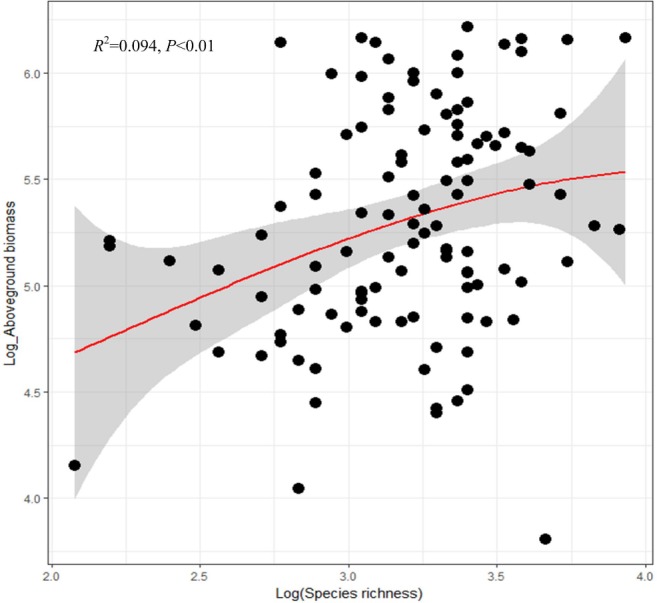
Relationship between species richness and aboveground biomass in a primary Pinus kesiya forest.The red solid line is from multiple OLS regression by adding the cubic term. Gray shaded areas show 95% confidence interval of the fit.